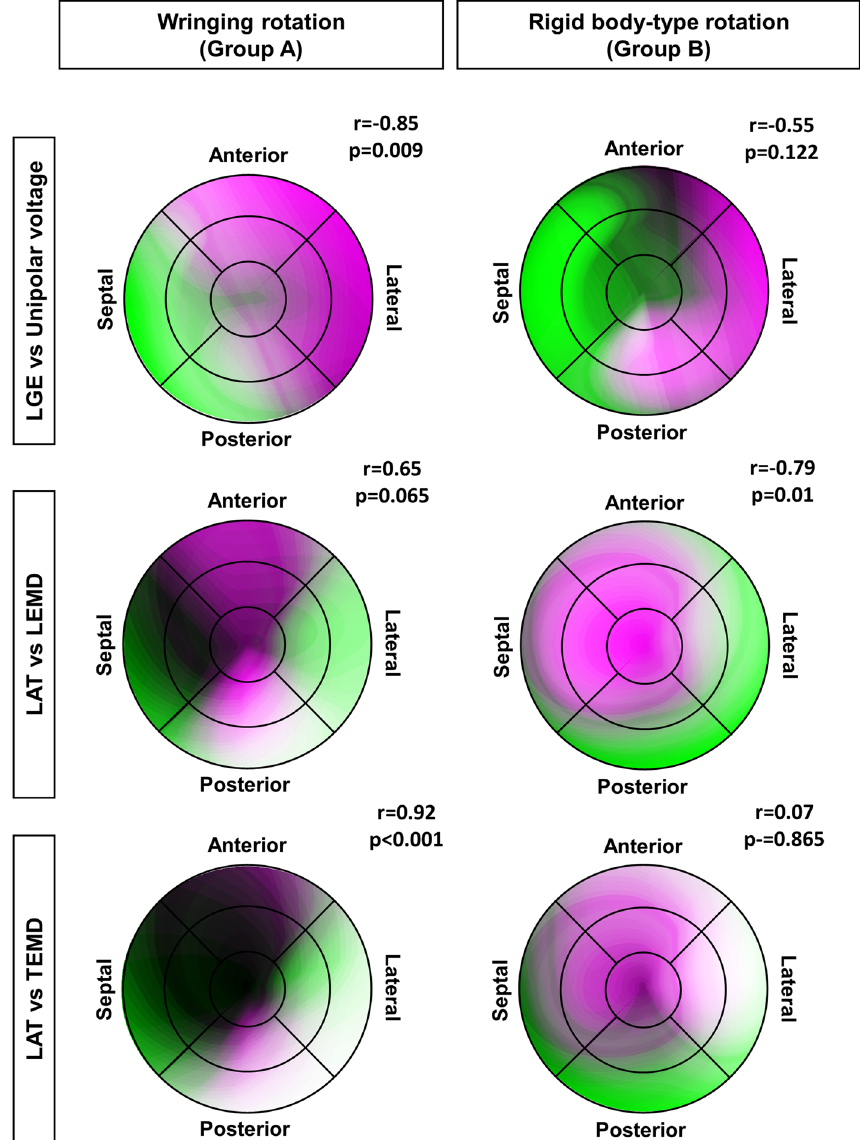
dark areas indicates higher positive